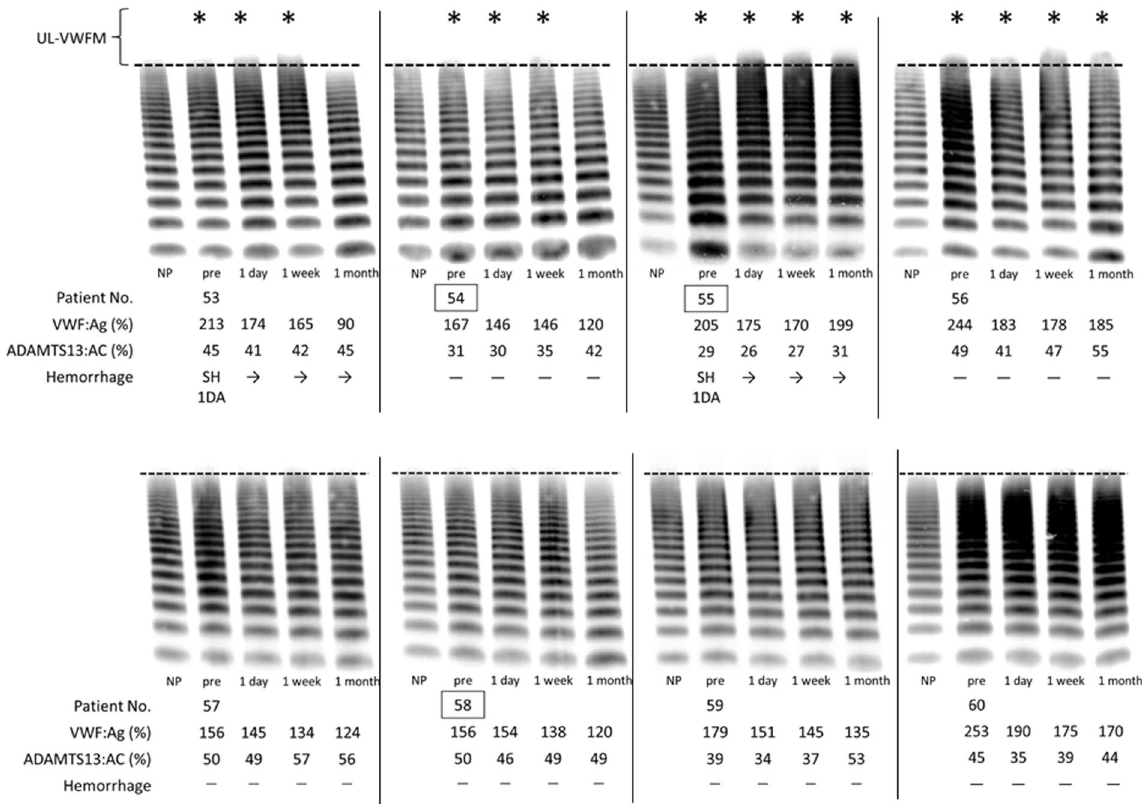
Figure 3. VWF multimer analysis before and after intravitreal injection of aflibercept. We performed VWF multimer analysis in 22 patients with exudative AMD received an intravitreal injection of aflibercept before and at 1 day, 1 week, and 1 month after injection. Of these, VWF multimer analysis of 8 patients (patient Nos. 53–60) were shown in this figure. Each patient number enclosed by a square indicates a patient with polypoidal choroidal vasculopathy (PCV). Patient Nos. 53 and 55 had subretinal hemorrhage and UL-VWFMs before treatment. Patient Nos. 54 and 56 also showed UL-VWFMs before treatment. Patient Nos. 55 and 56 had UL- VWFMs even at 1 month after injection. Asterisks indicate UL-VWFM positivity. NP: normal pool